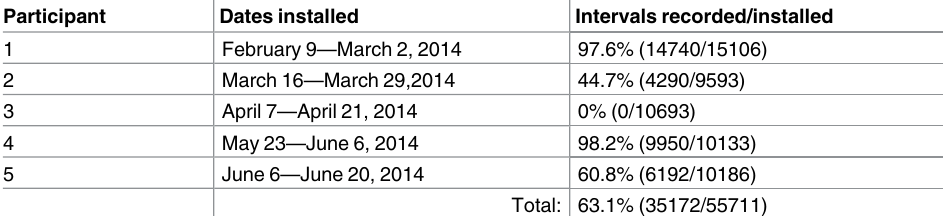
Table 3. Total two minute intervals installed and captured by SmartNet.